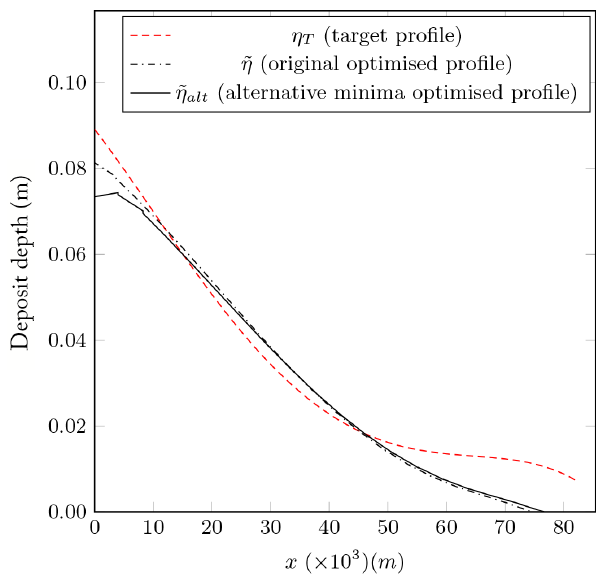
Figure 8. The dimensional deposit output e η from the optimised de- posit output from the initial parameter guess (Eq. 74) and the dimen- sional deposit output e η alt from an alternative minima achieved by using the initial parameter guess (Eq. 78) shown against the fourth- order polynomial target deposit profile, η T